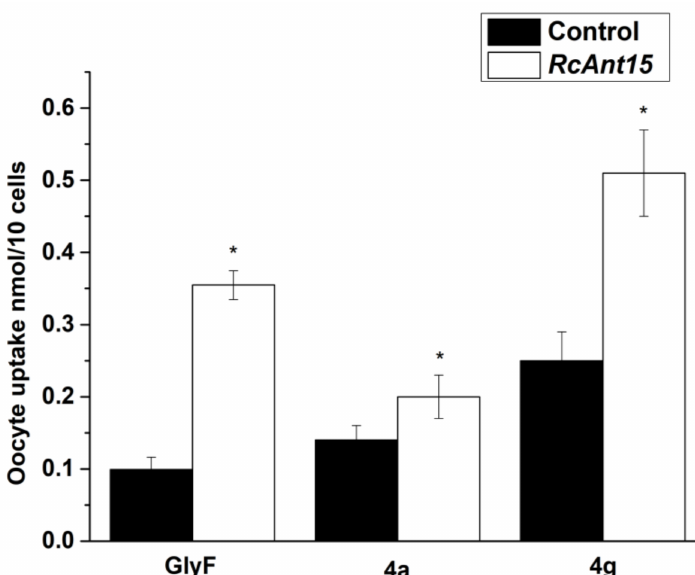
Figure 2. Uptake of GlyF, 4a , and 4g by Xenopus oocytes after treatment with 100 µ M of conjugates at pH 5.6 for one hour. Each oocyte was injected with 18.4 nL of amino acid transporter RcANT15 cRNA (white column), and oocytes injected with the same volume of Nuclease-Free water were used as a control (black column). Data (mean ± SE, n = 4) columns marked with * are significantly different from the control set, as determined by Mann–Whitney U test ( p < 0.05). Data on GlyF were from Xie et al.